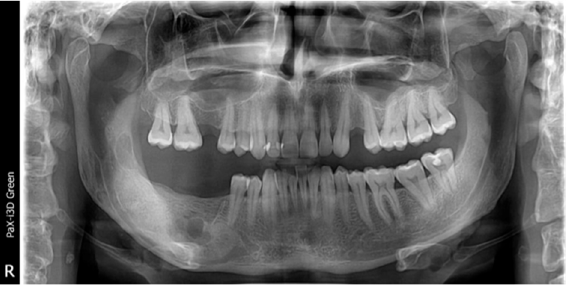
lytic lesions: one at the apical region of tooth #46 (arrow), without a mandibular canal involved, and another at the anterior margin of the ascendant ramus (arrow); ( b ) the CBCT, coronal view of the affected ascending ramus; ( c ) the CBCT, coronal view highlights the panoramic radiograph findings; ( d ) the CBCT, sagittal view demonstrates the lesion contact with the molar #46.